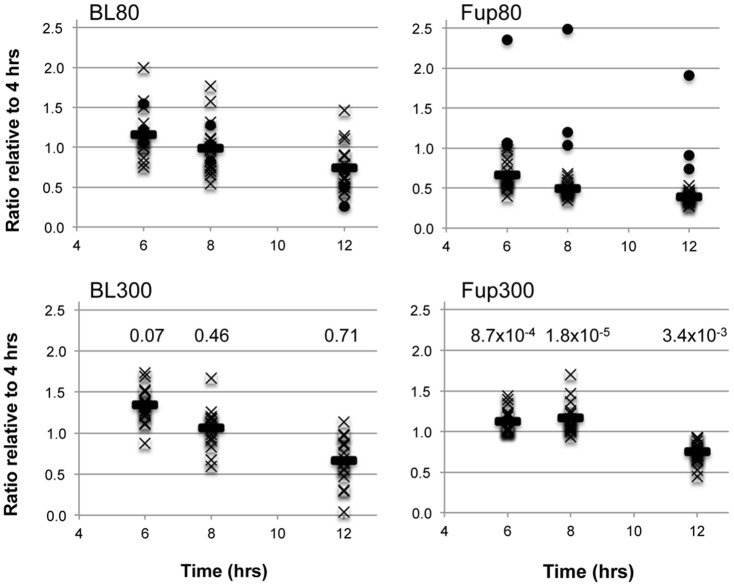

In vitro angiogenesis assay with isolated MPs.Circulating MPs were isolated from patient's plasma before (BL) and after (Fup) ECP therapy at 80 mmHg (top row) or 300 mmHg inflation pressure (bottom row). Displayed are numbers of meshes formed by HUVECs relative to the four-hour time point. The horizontal bars represent the mean value at each time point. The dots in the BL80 and Fup80 plots are the triplicate values measured for patient #14. The mean values between the 80 mmHg and 300 mmHg inflation pressure were tested for their likelihood to be the same by Student's t-test (two-tailed, equal variance) and P values at each time point are given in the bottom row graphs.